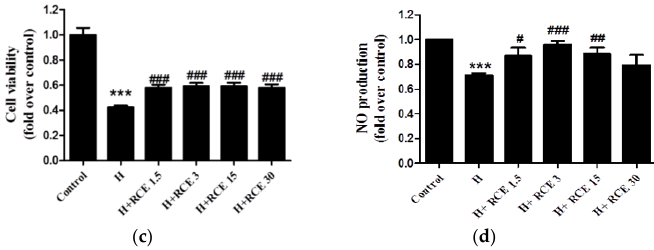
Figure 2. Effect of Rhodiola crenulata root extract (RCE) on cell viability ( a ) and nitric oxide (NO) production ( b ) in human umbilical vein endothelial cells (HUVECs) under hypoxic conditions. HUVECs were exposed to hypoxia (1% O 2 ) with or without RCE treatment (μg/mL) for 24 ( a ), 48 ( b ), and 72 h ( c ). Cell viability was measured by Cell Counting Kit-8 (CCK-8 kit), and the supernatant (48 h) was collected for Griess assay ( d ). Results represent the mean ± SEM ( n = 6). *** p < 0.001 versus control; # p < 0.05; ## p < 0.01; ### p < 0.001 versus hypoxia.